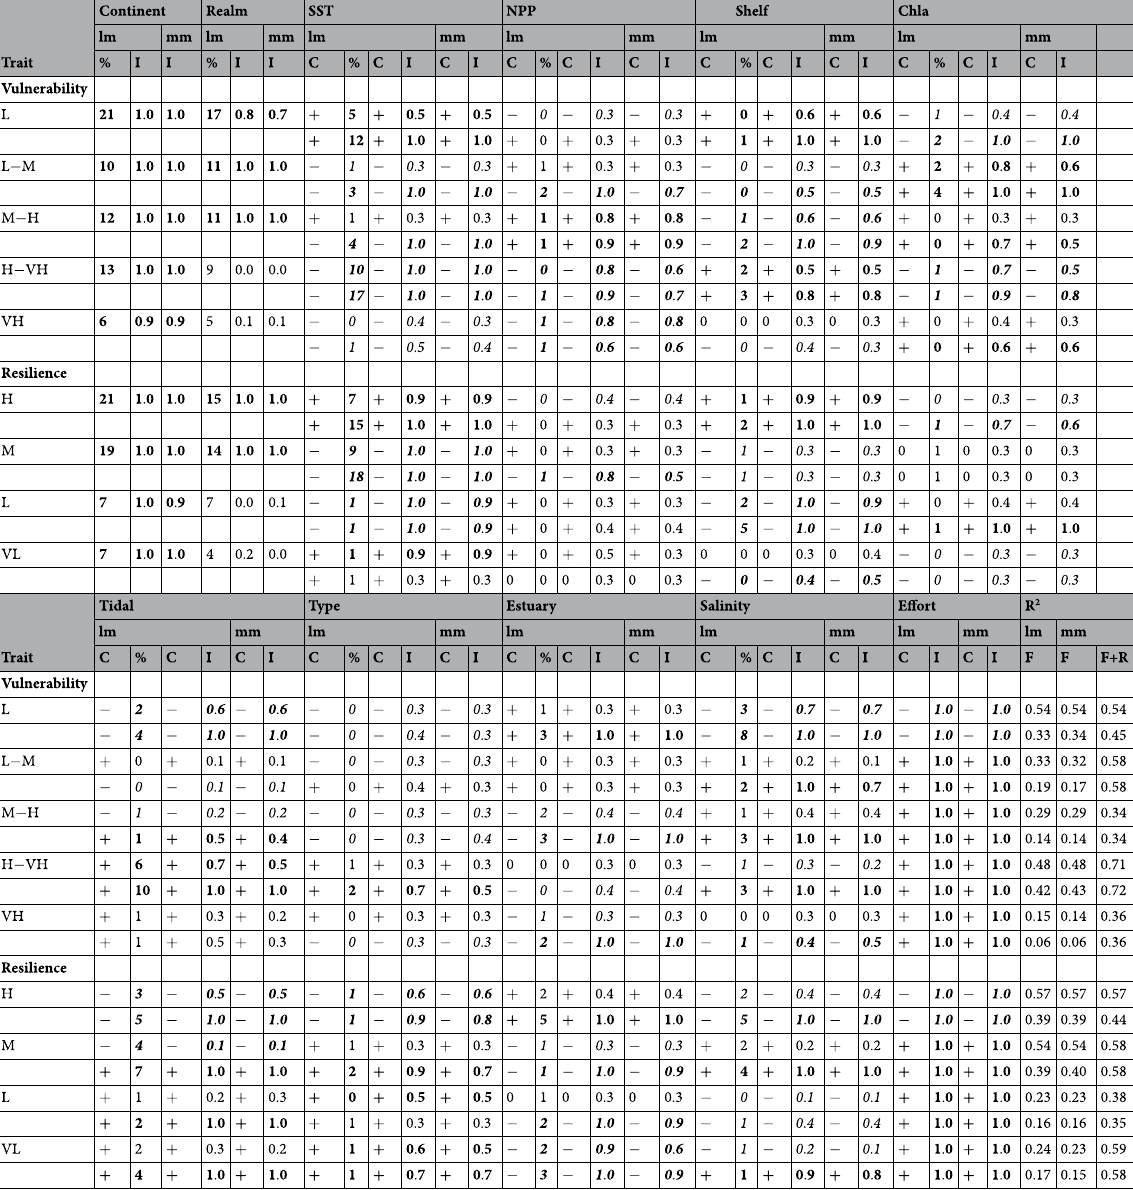
Table 2. Effect of ecosystem features (in columns) on “relative taxa richness” of fish vulnerability and resilience (in rows) among estuaries distributed worldwide, according to the fitted linear models (lm) and linear mixed models (mm).Fish vulnerability categories are: low (L), low to moderate (L-M), moderate to high (M-H), high to very high (H-VH) and very high (VH). Fish resilience categories are: high (H), medium (M), low (L) and very low (VL). For each trait category, we built two alternative models (in rows): with and without biogeographic variables (respectively, upper and lower row). To explore lm and mm, we used a multimodel procedure: the table shows the predictor coefficient in lm (represented in the table as C, shown only as “ + ” if positive or “ − ” if negative; R package relaimpo), the importance of each predictor to deviance in lm (represented in the table as %, between 0–100%; R package relaimpo), and the relative importance of each predictor to trait variation in lm and mm (represented in the table as I, between 0–1; package MuMIn). The table also shows: for lm, the pseudo R 2 of the fitted lm; for mm, the conditional pseudo R 2 (fixed effects) and the marginal R 2 (fixed and random effects). Ecosystem features are: continent and marine biogeographic realm, sea surface temperature, terrestrial net primary productivity, continental shelf width, marine chlorophyll a, tidal regime (from microtidal, mesotidal, to macrotidal), estuary type (from temporarily open to open), estuary area, salinity type (from regular, regular-hyperhaline to hyperhaline) and sampling effort (in total sampled area). Continuous predictors were log-transformed. Fish traits are species intrinsic vulnerability and resilience (total number of samples is 530, for a total of 378 estuaries). Values in italic font are predictors that have C (coefficient) below 0, and values in bold font are predictors that have I (importance) above